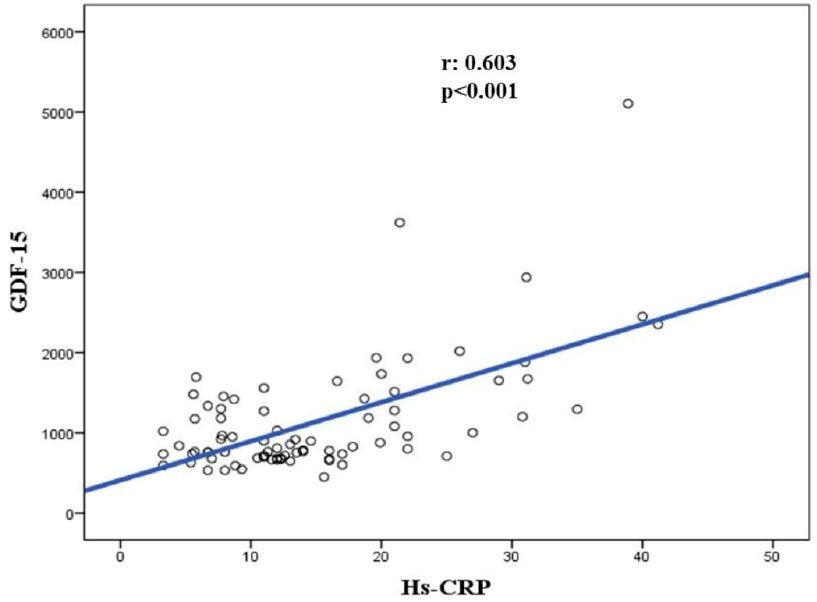
Figure 2. Correlation between hs-CRP and GDF-15 levels.